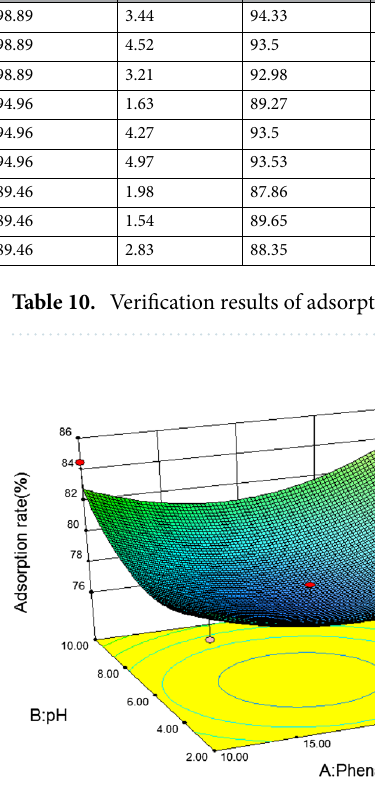
Figure 10. Effects of initial phenanthrene concentration and pH on silty sand adsorption